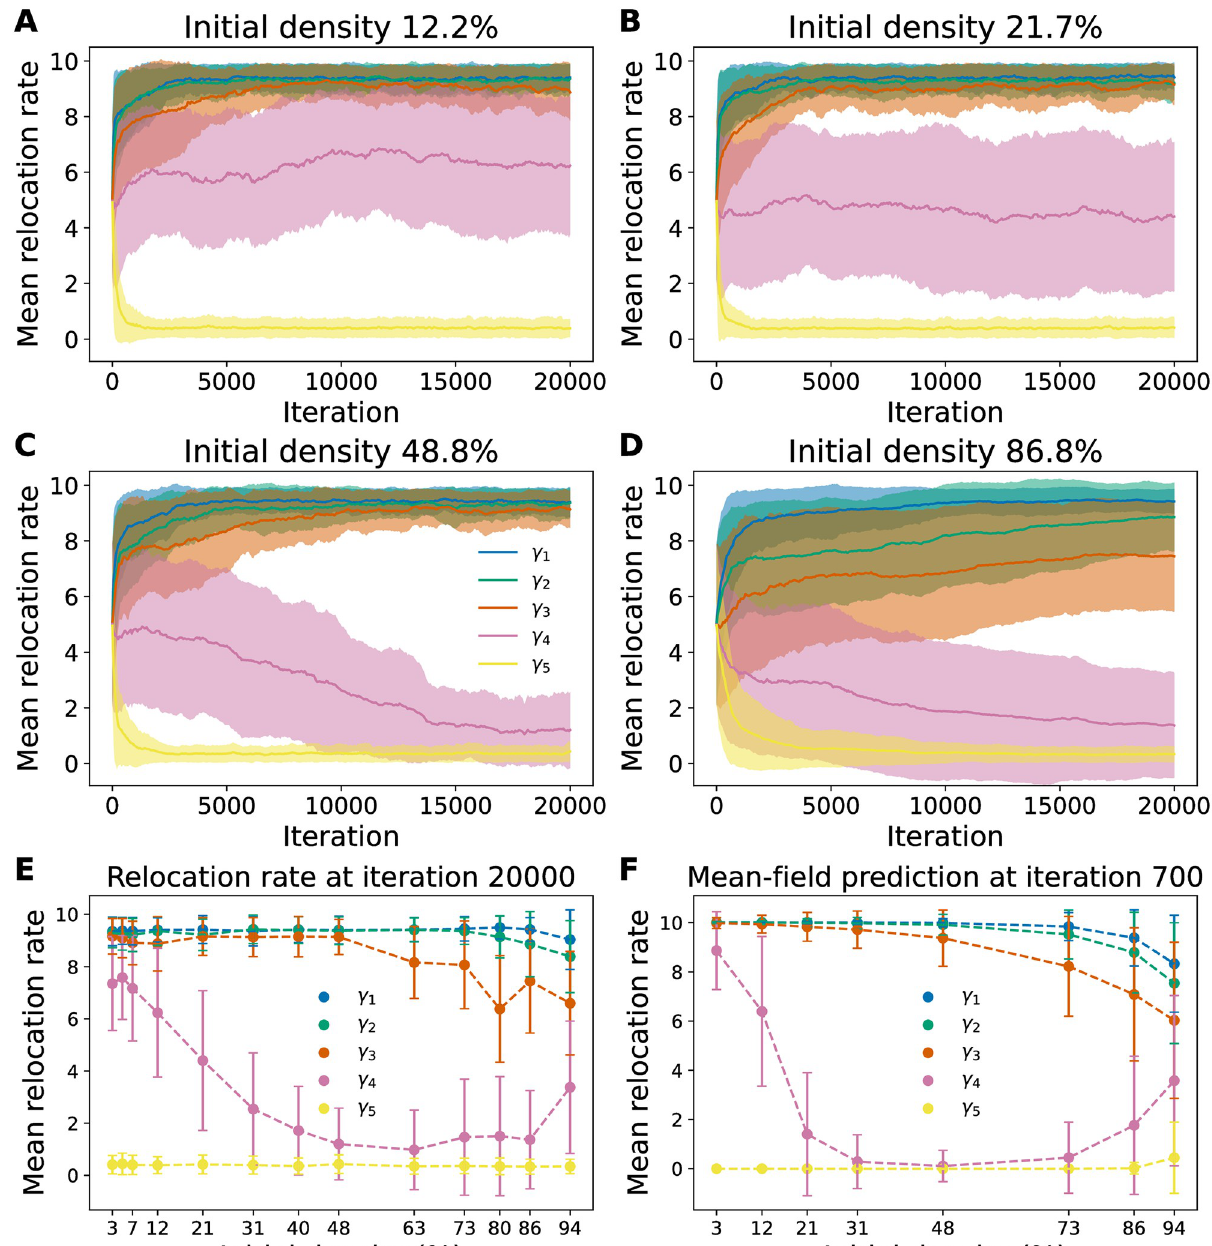
Fig 4. Higher initial densities alter the most competitive phenotypes. A-D. The evolution course for populations of agents starting with different initial densities: 12.2%, 21.7%, 48.8%, and 86.8%, respectively; c.f. Fig 2E at 3.1% density. The initial density is varied by fixing the initial population size at 500 and decreasing the environment size L × L with L = 128, L = 64, 48, 32, and 24. We observe a systematic shift of the most competitive phenotypes; in particular, the fourth phenotype component γ 4 decreases as the initial density increases. E. Mean values of γ 4 after 20000 iterations in the agent-based model as a function of the initial density, showing the change in the most competitive phenotype. At ultrahigh densities, e.g. 94%, there is no space for agents to move or give birth, resulting in little change in the initially uniform phenotype distribution. F. Mean-field model predictions of the most competitive phenotypes as a function of initial density after 700 iterations. A birth rate of b 5 = 5 is used in the mean-field model so that h γ 4 ( t ) i converges to 10 at low densities.